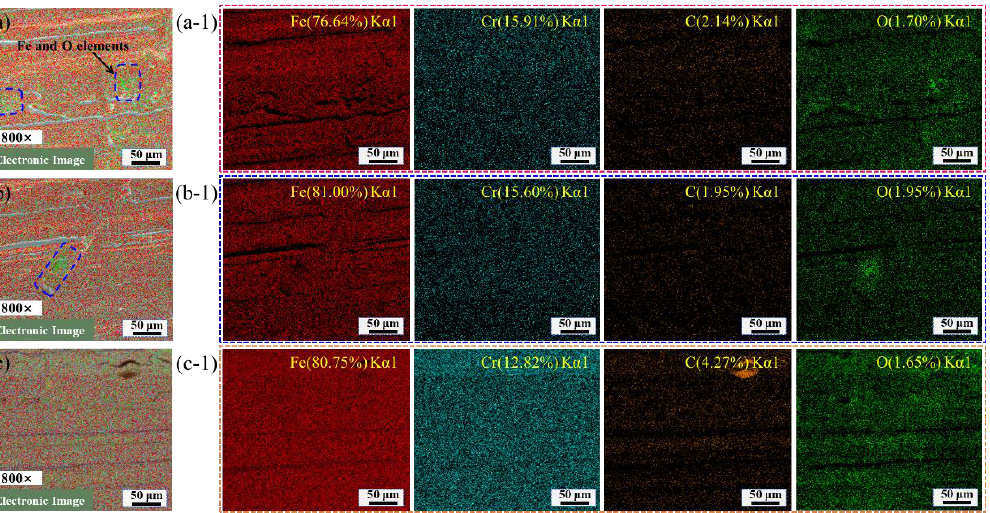
Figure 13. The surface element distribution of polished surfaces with scanning speed of 250 mm/min. ( a ) Zone 1; ( b ) Zone 2; ( c ) Zone 3; ( a-1 ) Main elements on the surface of Zone 1; ( b-1 ) Main elements on the surface of Zone 2; ( c-1 ) Main elements on the surface of Zone 3.